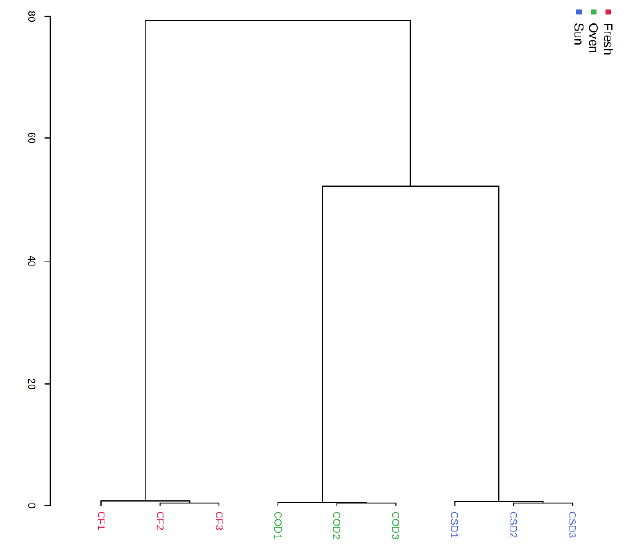
Figure 5. Cluster analysis of Chinese variety of volatile oils after heat treatment.